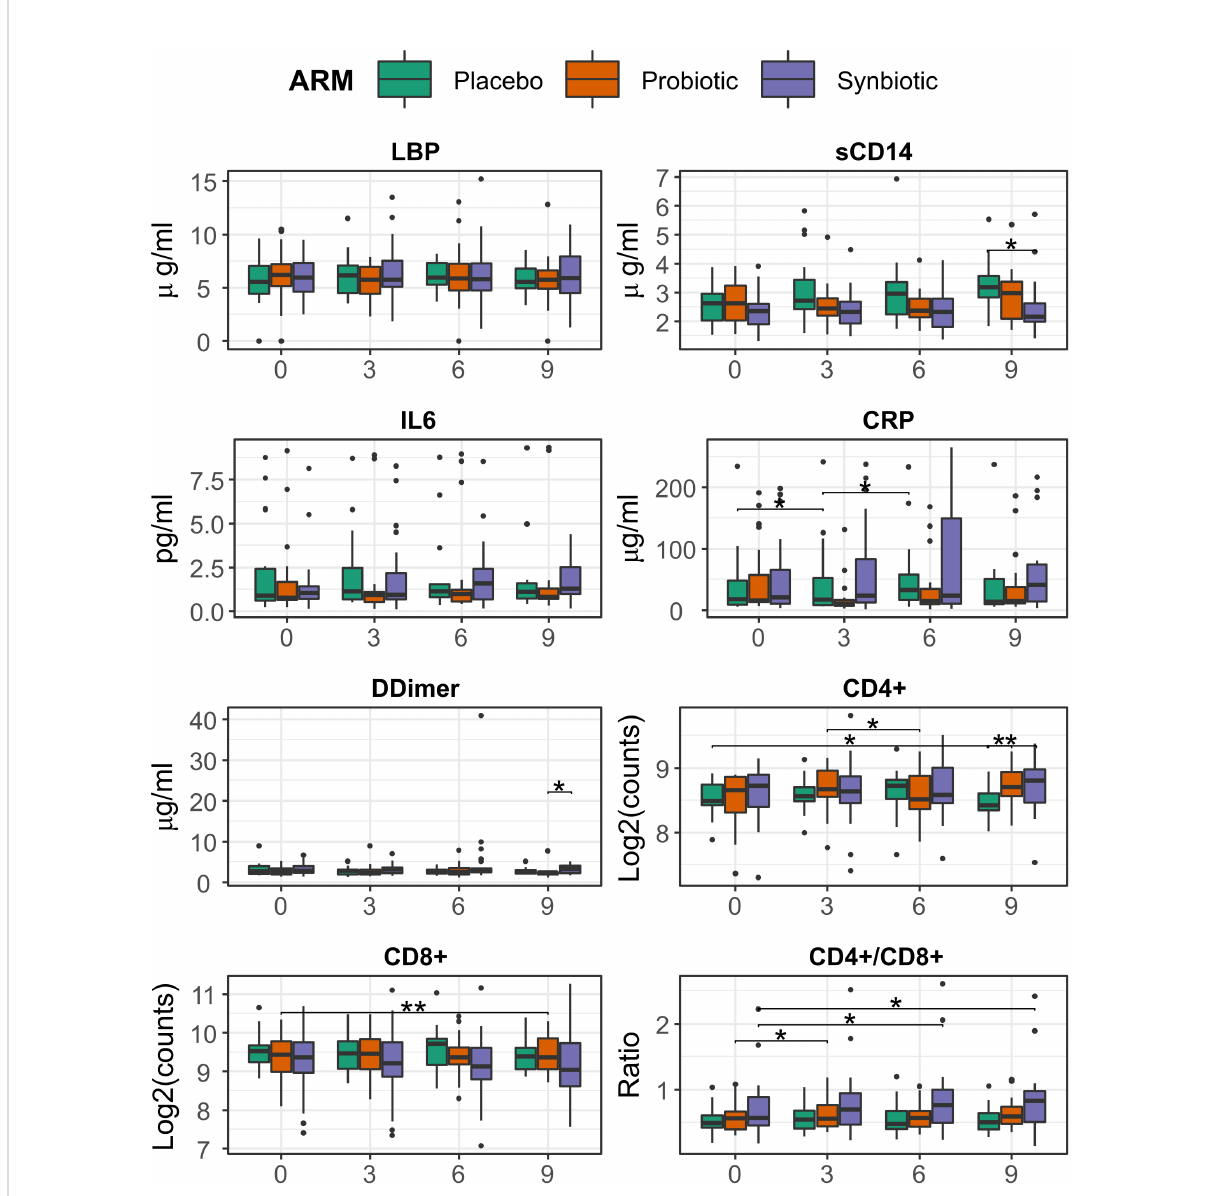
FIGURE 2 Evolution of T-cell counts, ratio, in fl ammation, and bacterial translocation markers between months 0 and 6, among treatment group. Comparisons within group and between time points were performed by Wilcoxon test, in its paired form for longitudinal differences and unpaired for cross-group comparisons. Signi fi cance was coded as follows: *(p < 0.05), **(p <